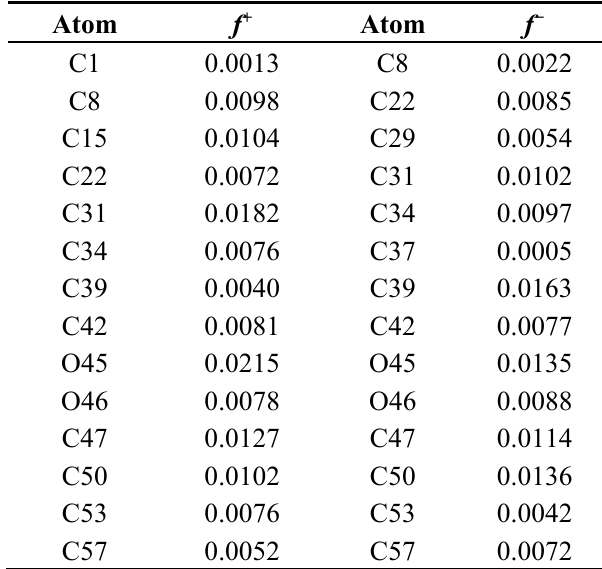
Figure 10. Mulliken atomic charges of atoms in the optimized structure of SB. Table 6. Fukui indices for non-hydrogen selected atoms in SB